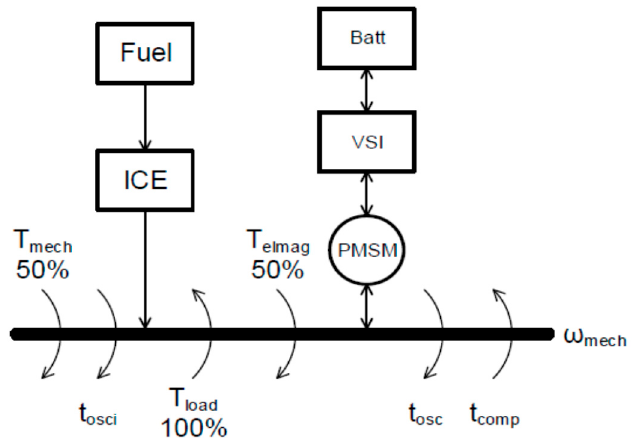
Figure A1. Arrangement of cooperating ICE engine and PMSM motor in the parallel HEV vehicle.